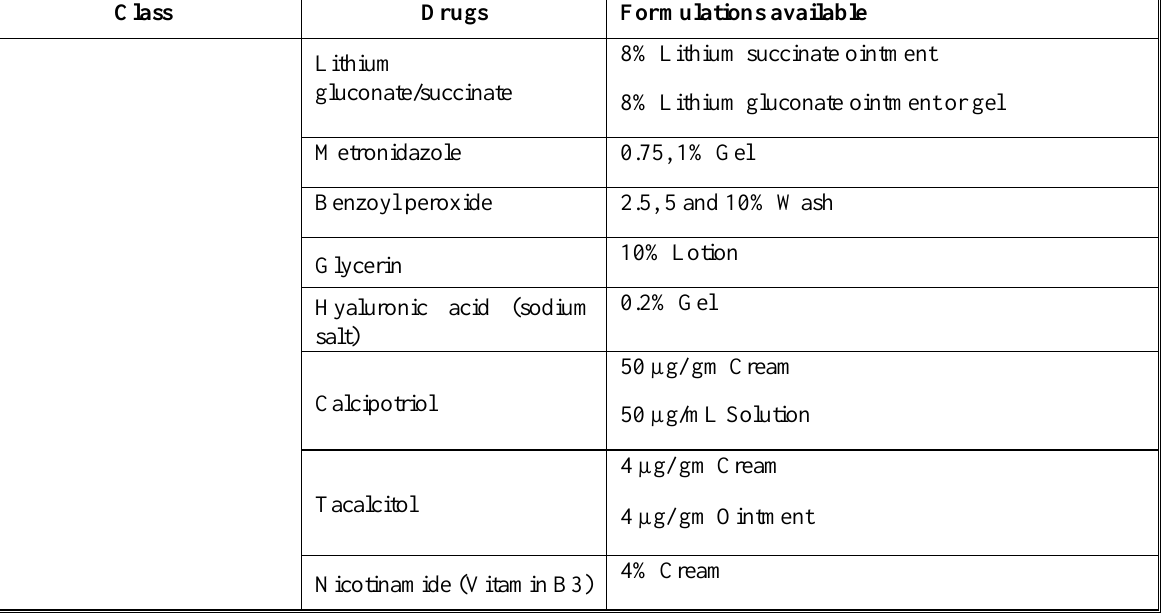
Continue table 1. Topical therapeutic agents used clinically for treatment of dandruff/SD *.